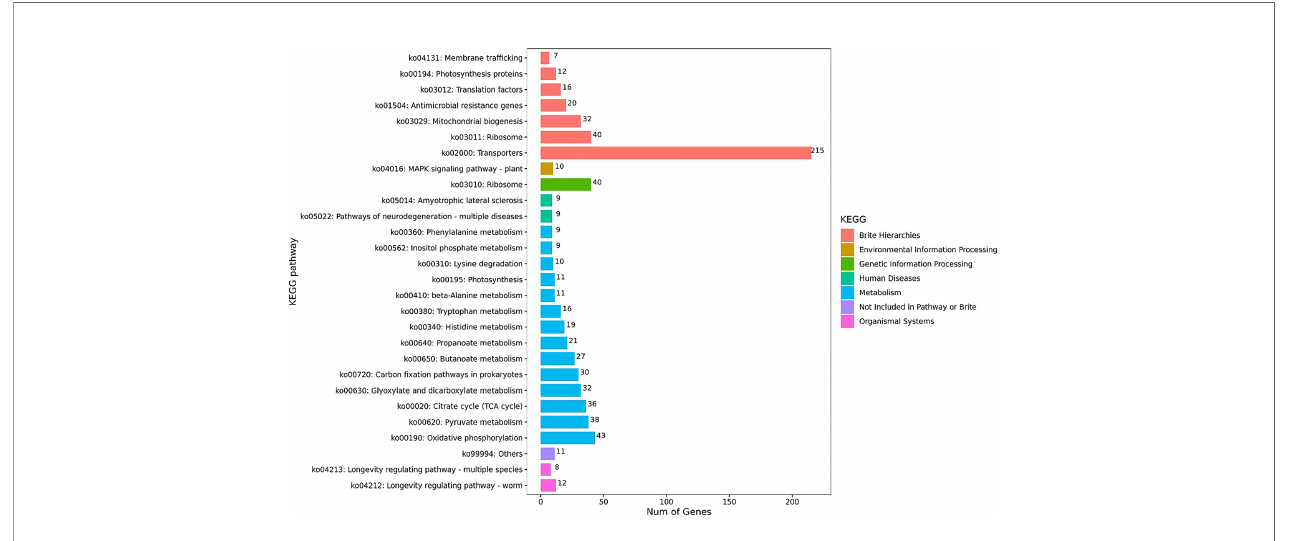
FIGURE 3 | KEGG enrichment analysis of